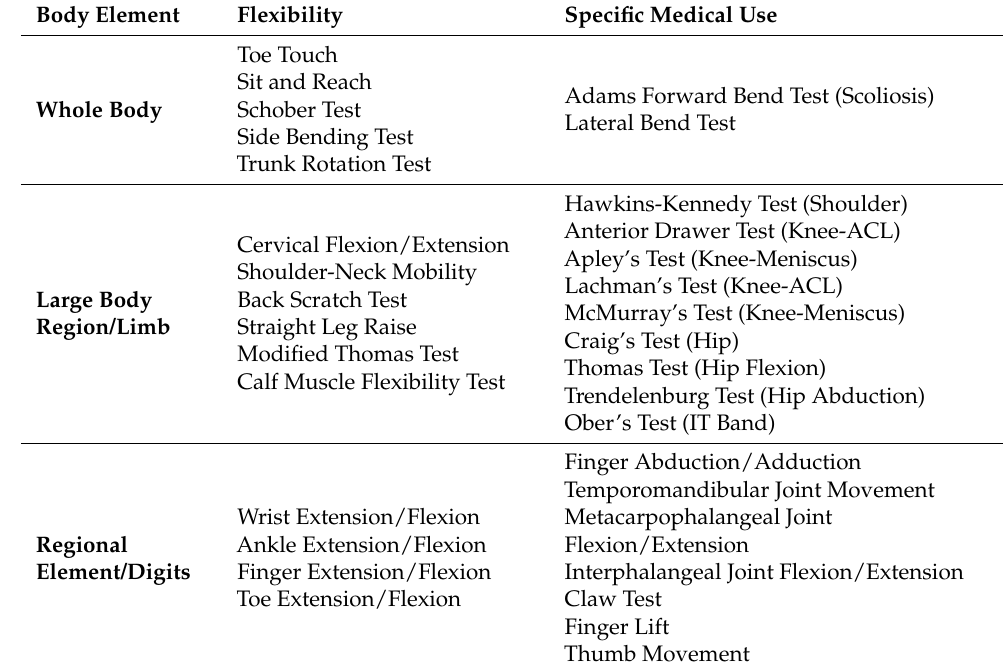
Table 2. Representative Application of MO 2 CA Based on Body Elements Measured. Body